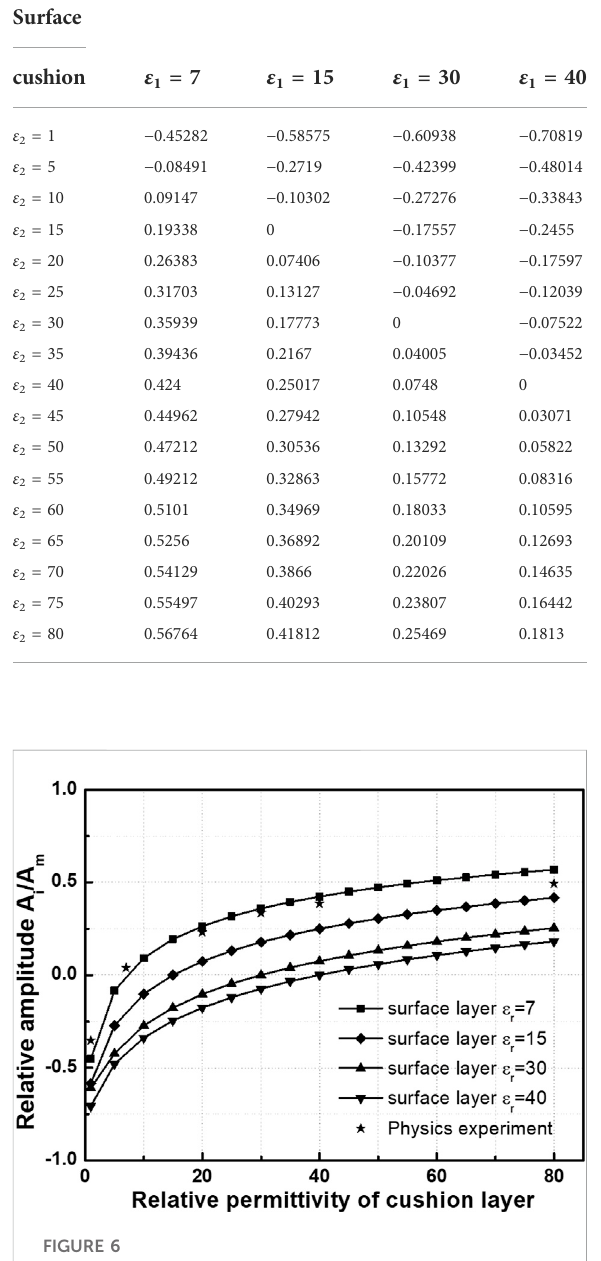
The fi ll soil of the Bell Tower pedestal bears some of the stress, and the increase in the water moisture of the fi ll soil must cause a decrease in the mechanical properties of the soil.